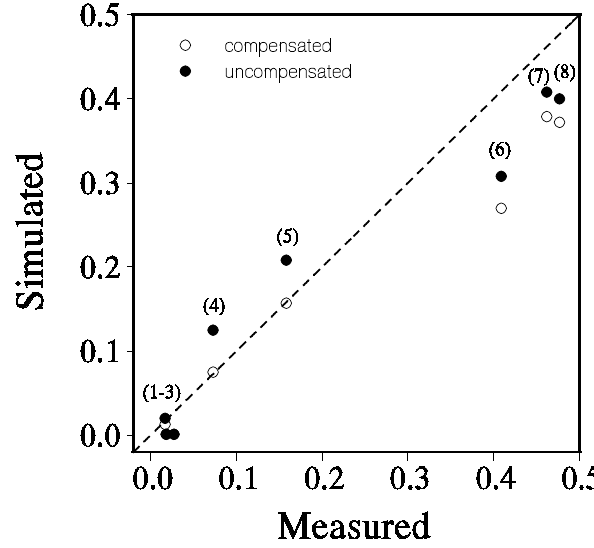
Fig. 8. The sensitivity of simulated total transpiration at Oklahoma City (see Table 2) to changes in the values of parameters controlling root length, root depth and leaf area. The base line parameter set is defined in Tables 1 and 3.